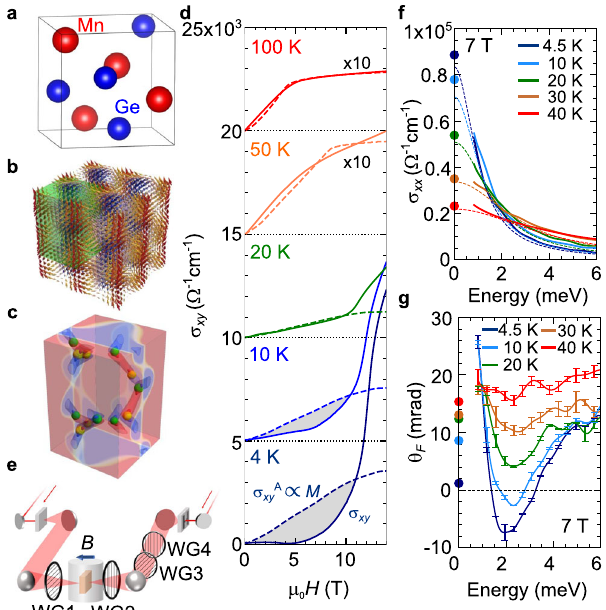
Fig. 1 Crystal structure, magnetic structure and basic properties of MnGe thin fi lm. a The crystal structure of MnGe. b The schematic illustration of the three-dimensional spin hedgehog lattice. c The positions of the emergent monopoles (green dots) and anti-monopoles (yellow dots) at zero magnetic fi eld in the green box of panel b 21 . The red and blue colors represent the positive and negative emergent magnetic fi elds, respectively. d The magnetic- fi eld ( H ) dependence of the Hall conductivity at each temperature (solid curves). The data are shifted vertically for clarity. The dashed curves ( σ xy A ) represent the estimated magnetic- fi eld dependence of the anomalous Hall effect estimated from the magnetization curves (see also the discussion in Supplementary Note 1). The shaded areas, which represents the deviation from σ xy A , are ascribed mainly to topological Hall effect (THE). e The schematic illustration of the experimental setup. The direction of the magnetic fi eld is parallel to the light propagation direction (Faraday con fi guration). WG1-4 are wire-grid polarizers. f The longitudinal terahertz conductivity spectra ( σ xx ( ω )). Filled circles at zero frequency are the DC values obtained from the transport measurement. Dashed lines are the fi ts with Drude formula (see the text). g The Faraday rotation spectra. Filled circles at zero frequency indicate the values expected from the DC transport properties (see Methods). The error bars indicate the standard